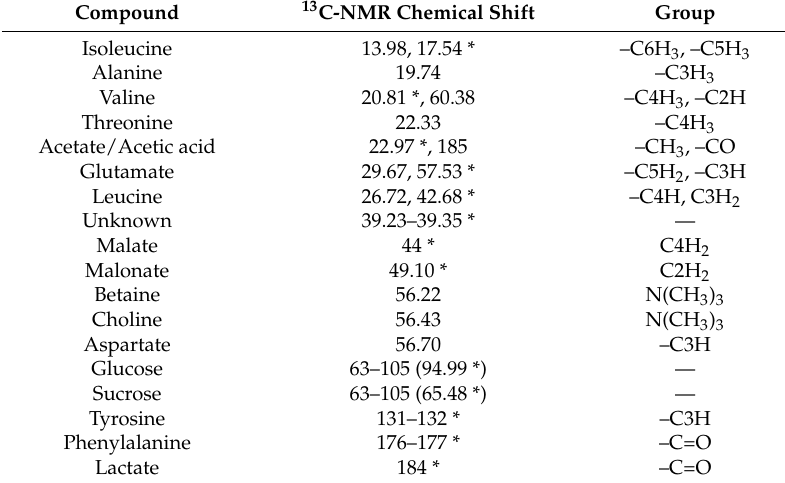
Table 1. Metabolites and their 13 C chemical shifts identified by the 600-MHz NMR